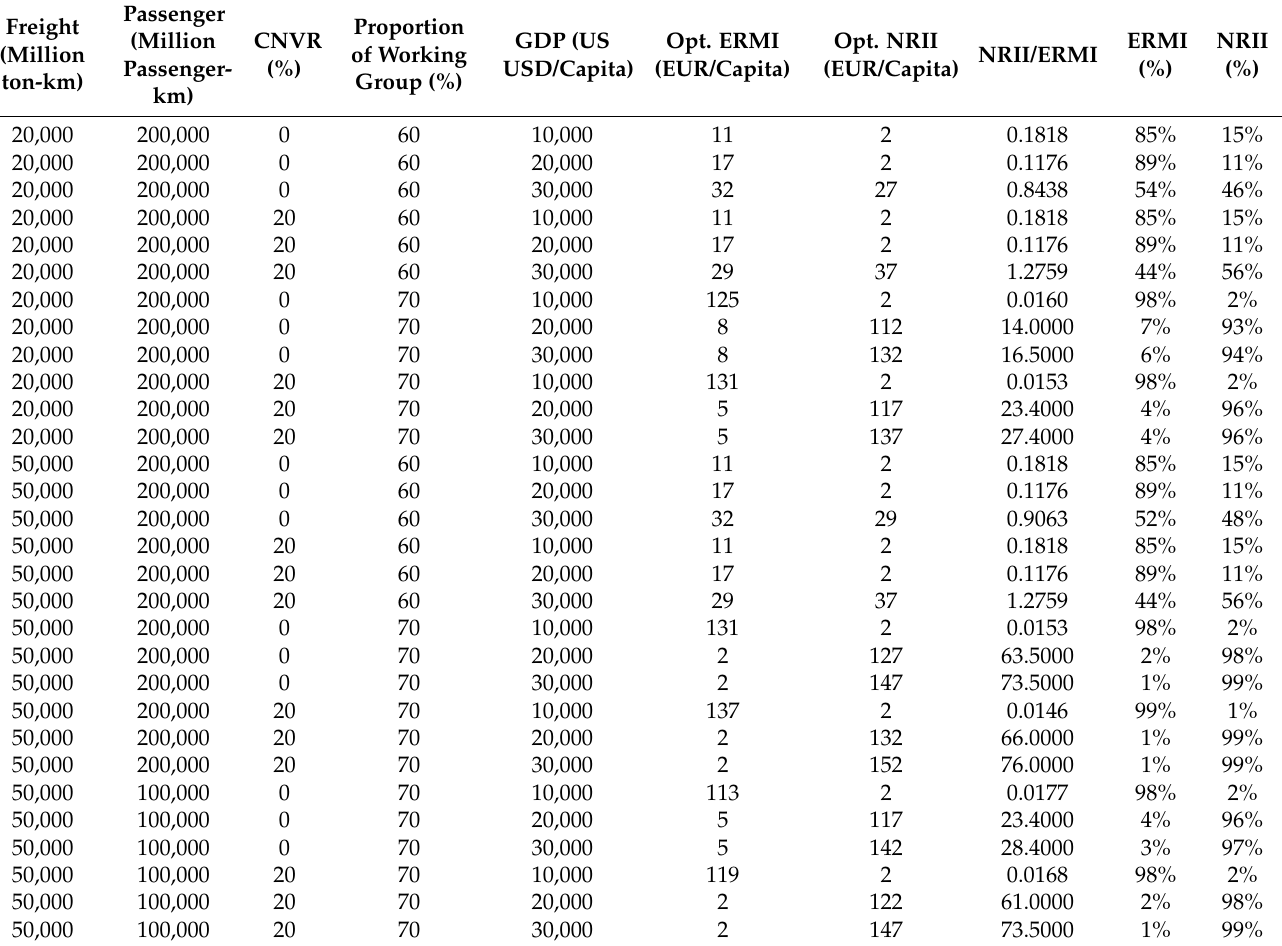
Table A1. Optimized annual ERMI and NRII per capita for population of 5